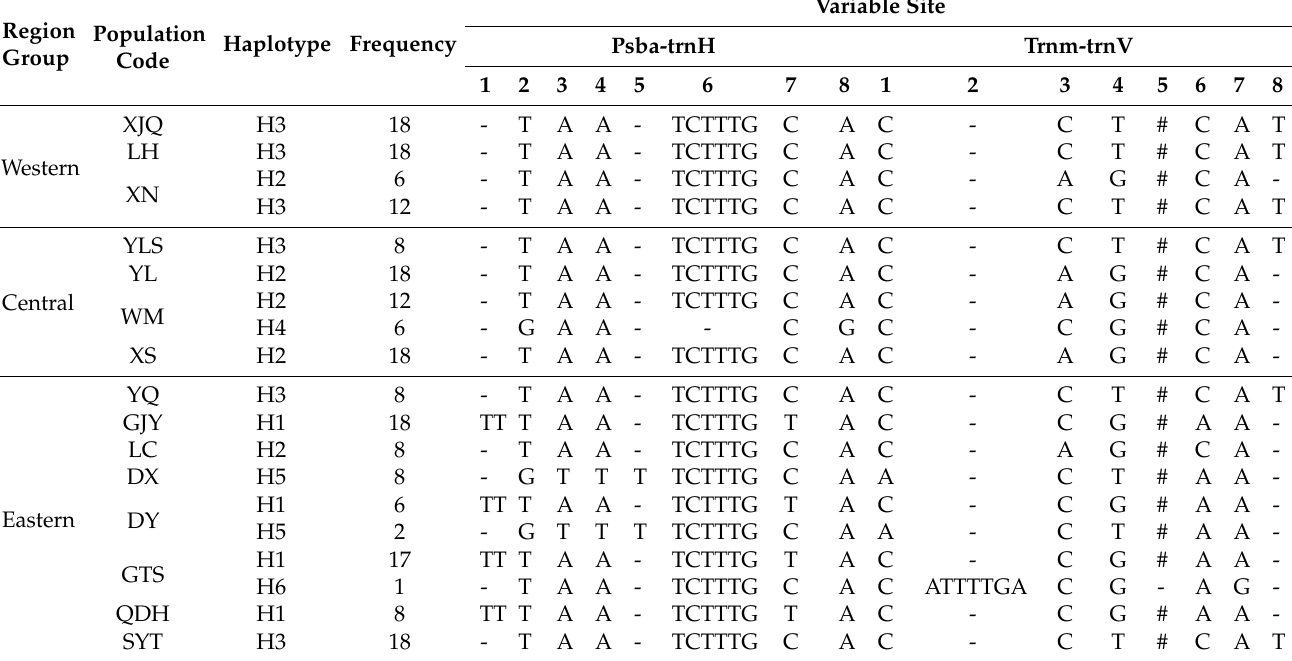
Table 2. Chloroplast DNA sequence variation and haplotypes revealed in this